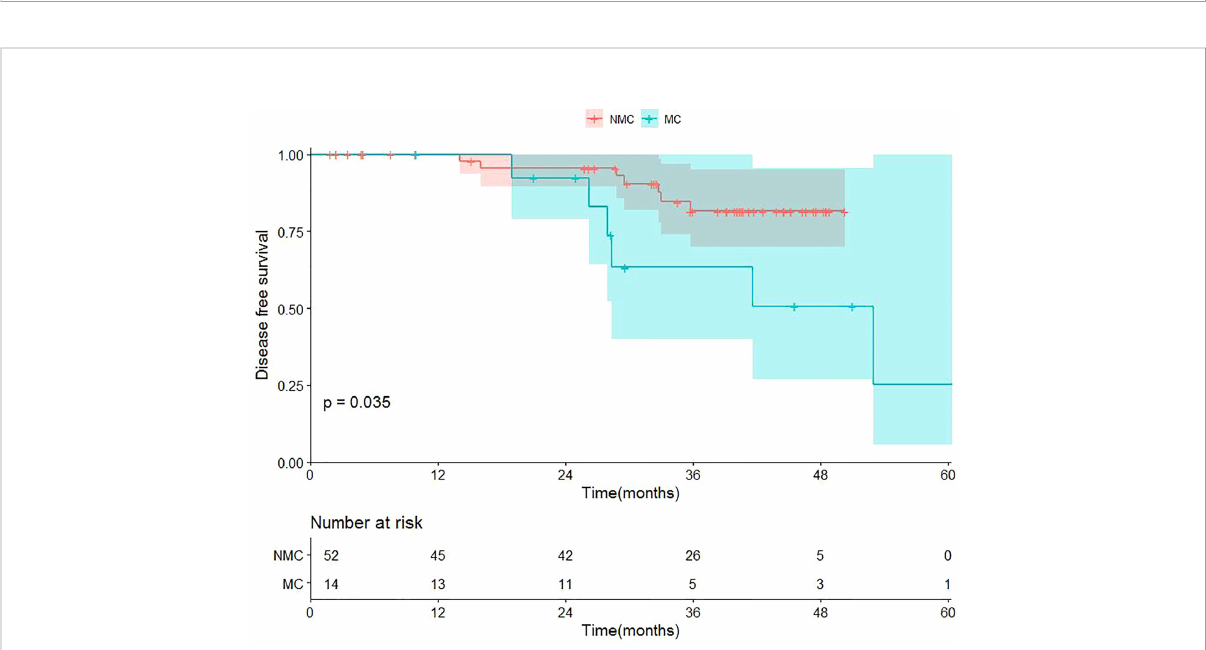
FIGURE 7 Kaplan-Meier survival curves of the cohort. TNBC-MC (abbreviation: MC), triple negative breast cancer-metaplastic carcinoma; TNBC-NMC (abbreviation: NMC), triple negative breast cancer - non metaplastic